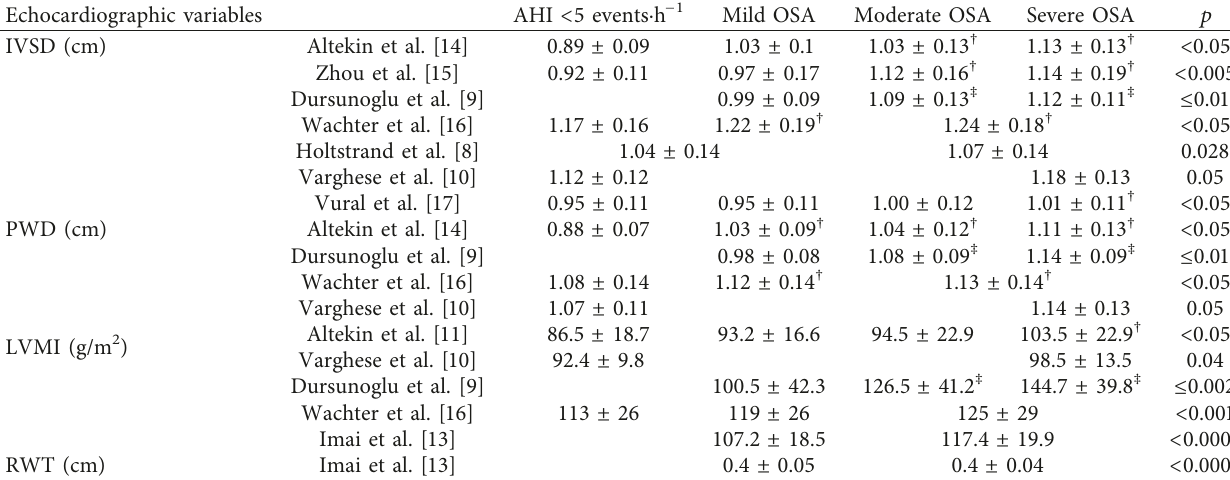
Table 2: Left ventricular bidimensional parameters in relationship with OSA severity.